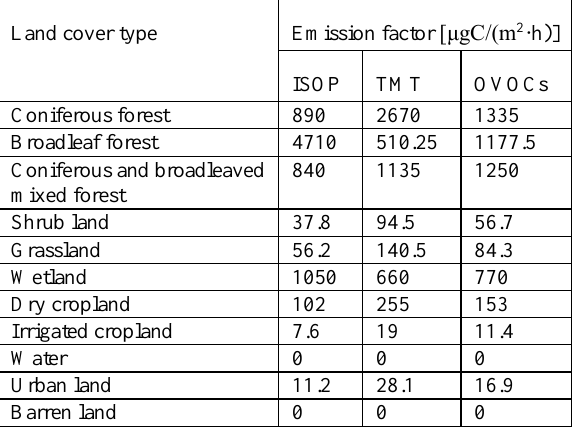
Table 1. Emission factors of each land cover type in this study